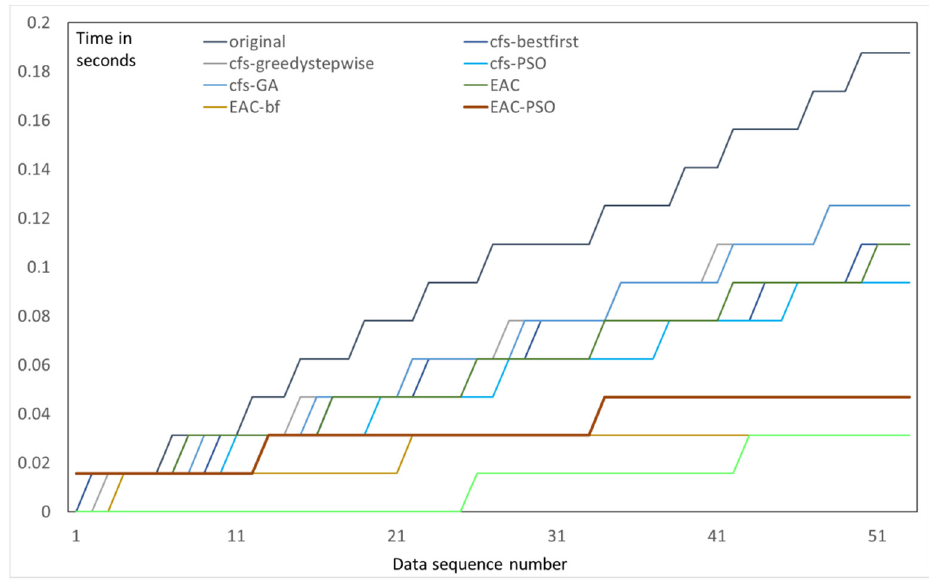
Figure 9. Comparative graph of time of the Hoeffding tree model coupled with seven preprocessing algorithms.